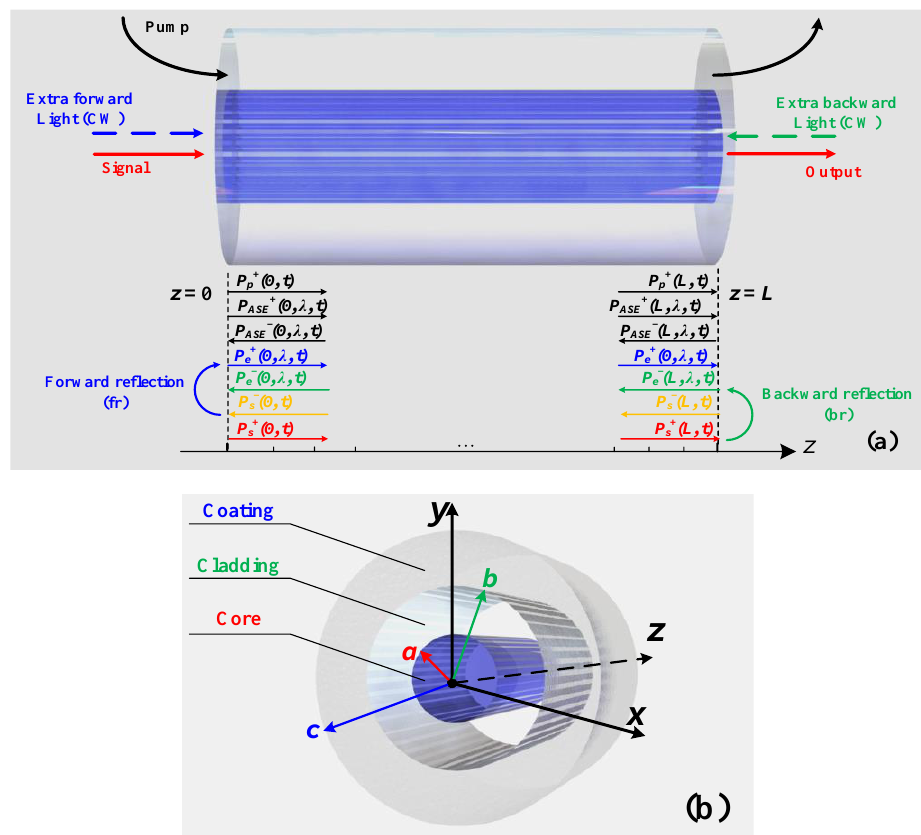
Figure 1. ( a ) Theoretical YDFA model shown in the axial direction. ( b ) Temperature distribution model shown in the radius direction of the gain fiber.